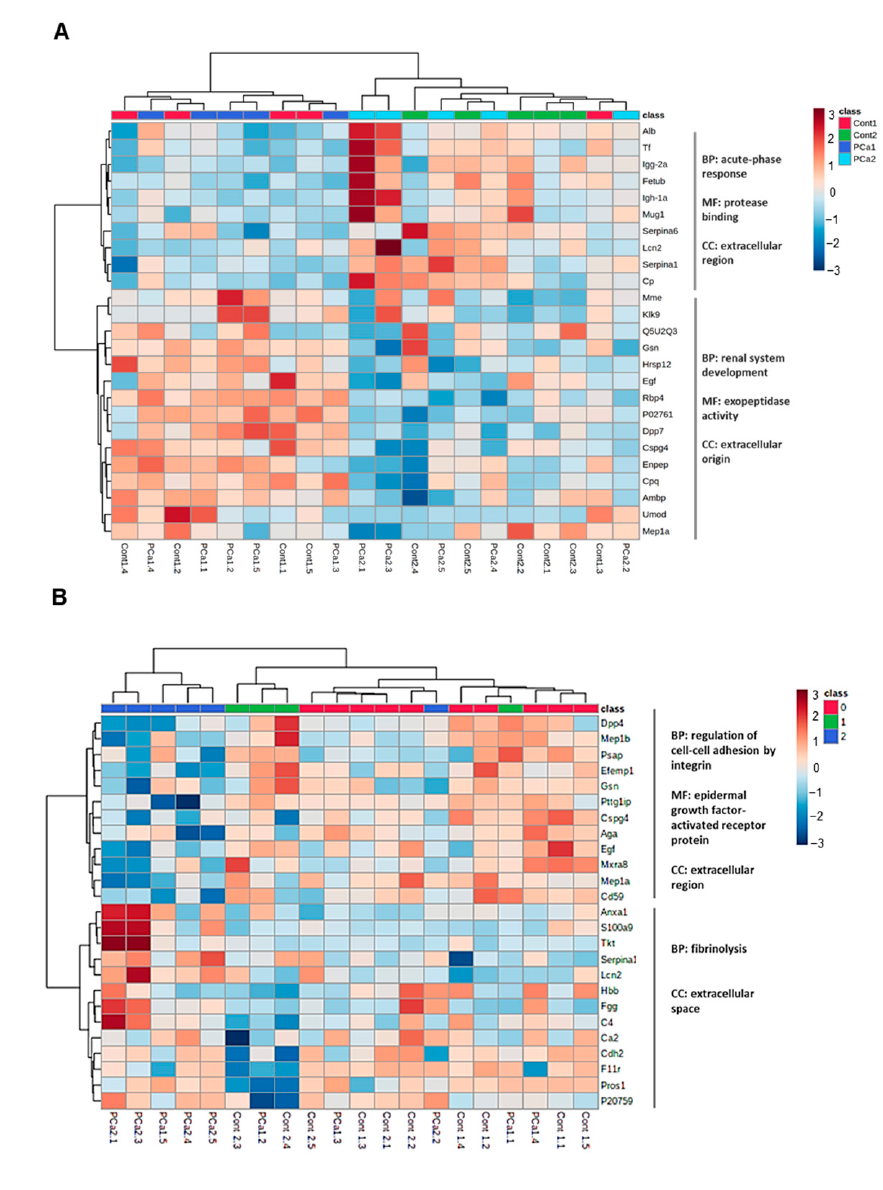
results, we compared them with recent human urinary proteomics data from the literature (Table S4) [15–17]. With respect to PCa1 vs. Cont1, four of six proteins have already been identified in the urine of PCa patients, namely retinol-binding protein 4 (RBP4). In PCa2 vs. Cont2, four of eight proteins were observed in the urine of PCa patients, such as enolase 1 (ENO1). The common proteins between the present study and the clinical studies showed the same trend in terms of abundance.